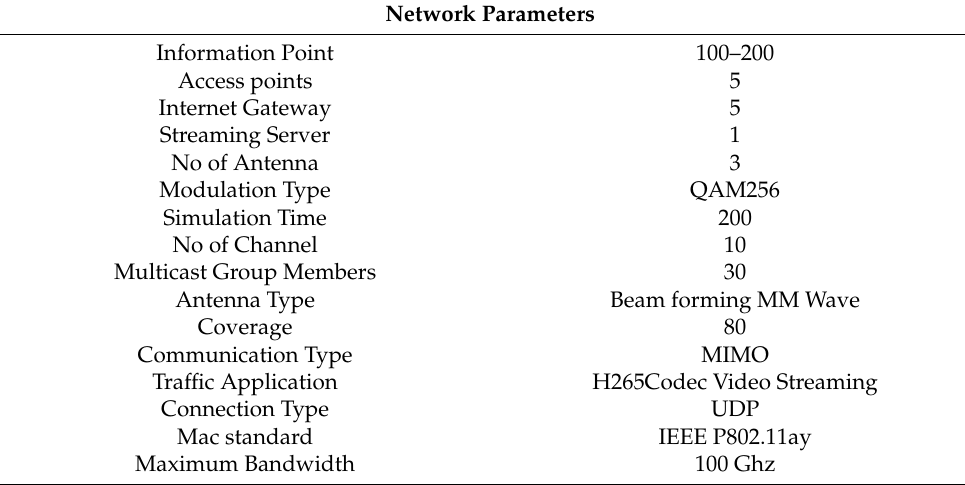
Table 5. Network